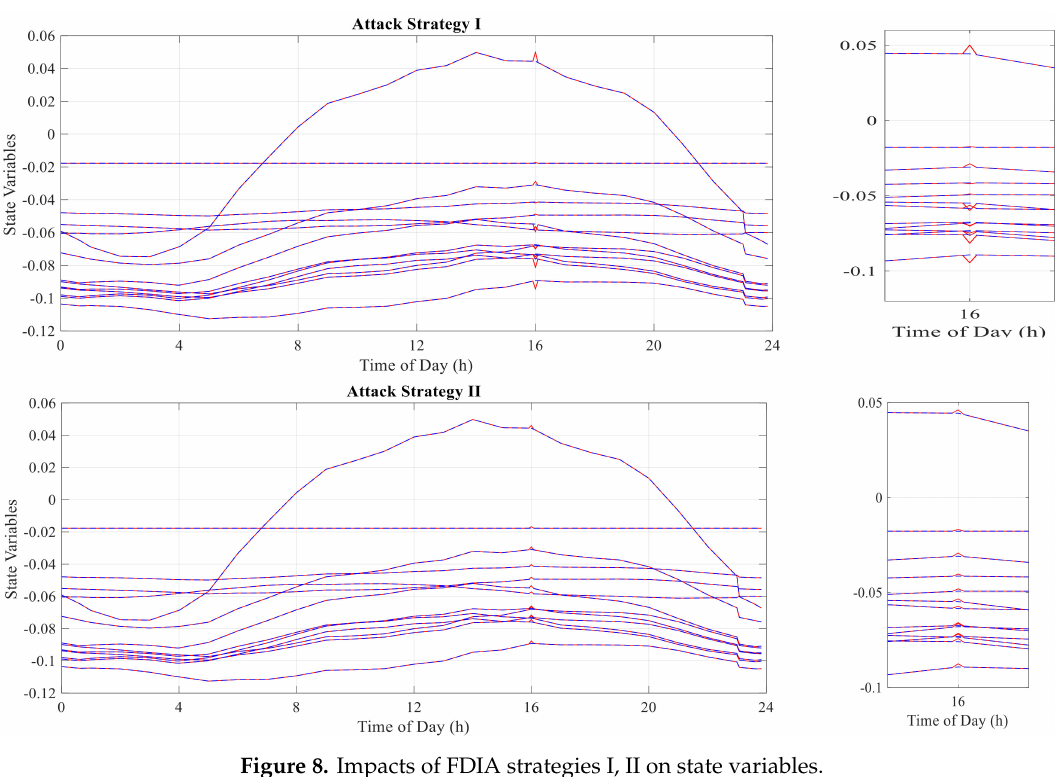
Figure 8. Impacts of FDIA strategies I, II on state variables.